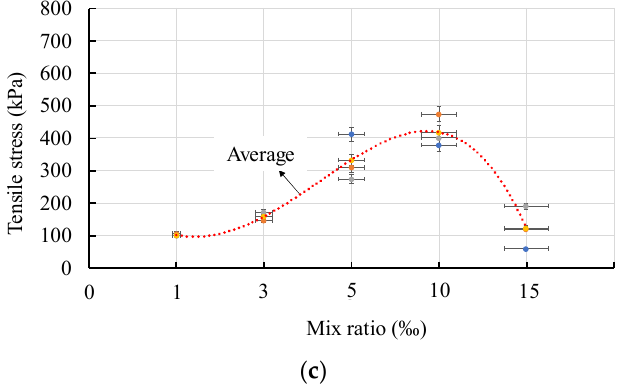
Figure 10. Tensile stress vs. mix ratio curves for different lengths of glass fibers. ( a ) Glass fiber length of 3 mm. ( b ) Glass fiber length of 6 mm. ( c ) Glass fiber length of 15 mm. Table 4. Experimental tensile strength values of tested specimens.